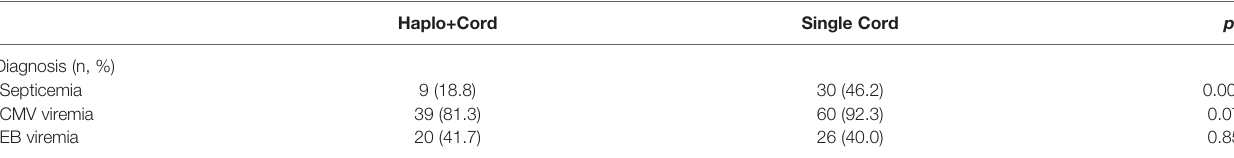
TABLE 5 | Septicemia, CMV, and EB infection after transplantation in two groups.